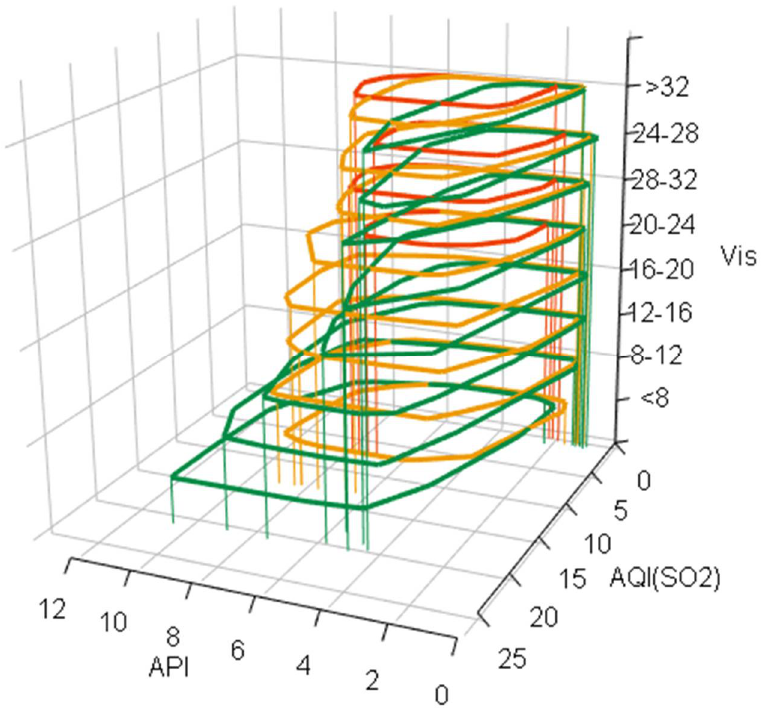
Figure A11. Effects of visibility-dependent air concentrations of SO 2 on the air pollution index for the rainy season in spring, summer and winter (Figures A11–A16 were executed using R package rgl [42,43]).